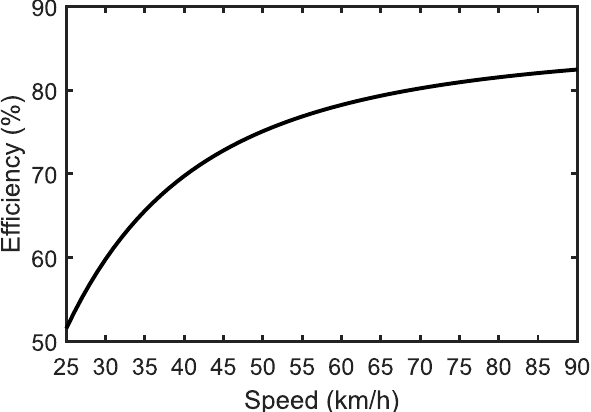
Figure 8. Proposed generator operating within urban driving cycles speed limits.